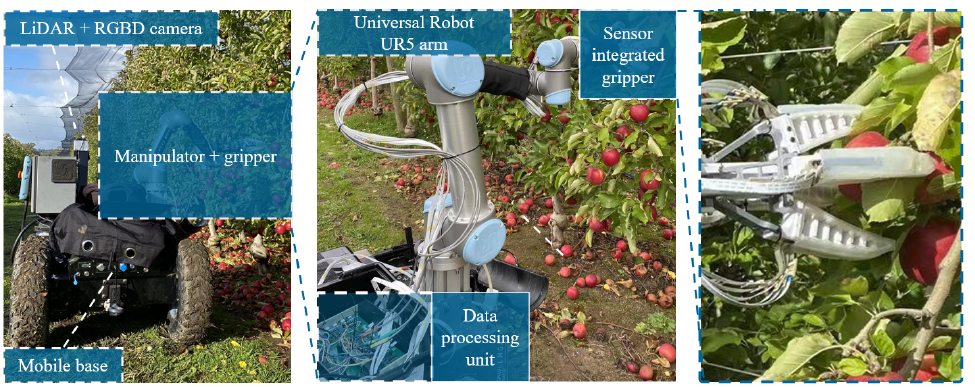
Figure 10. Experiment setting of grasp manipulation.